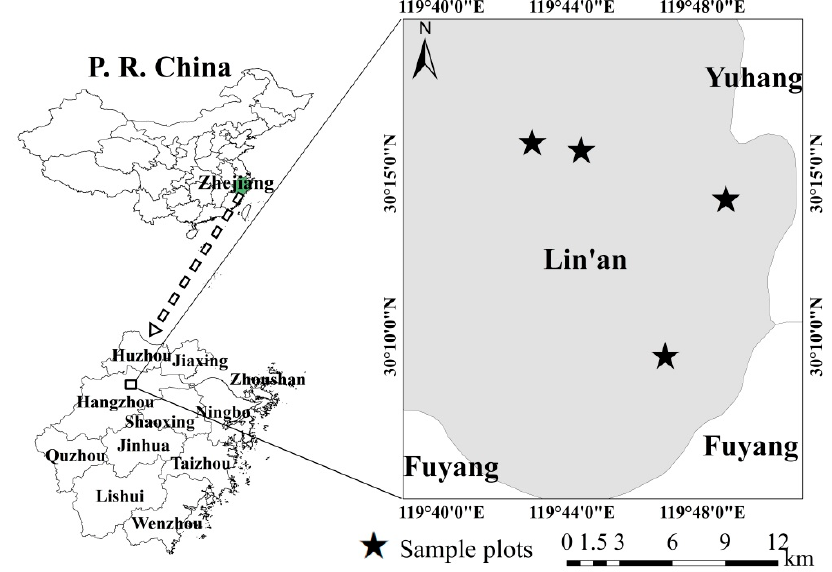
Figure 1. Study area in Lin’an.